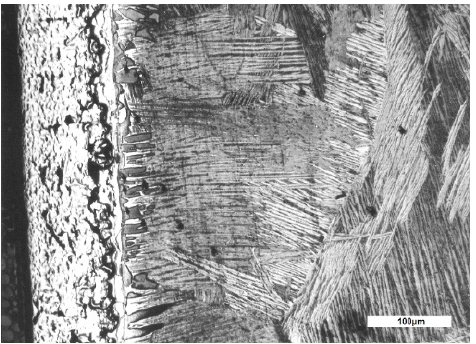
Figure 2. Microstructure in section of the sample treated 60 min at 1050 °C, MO.